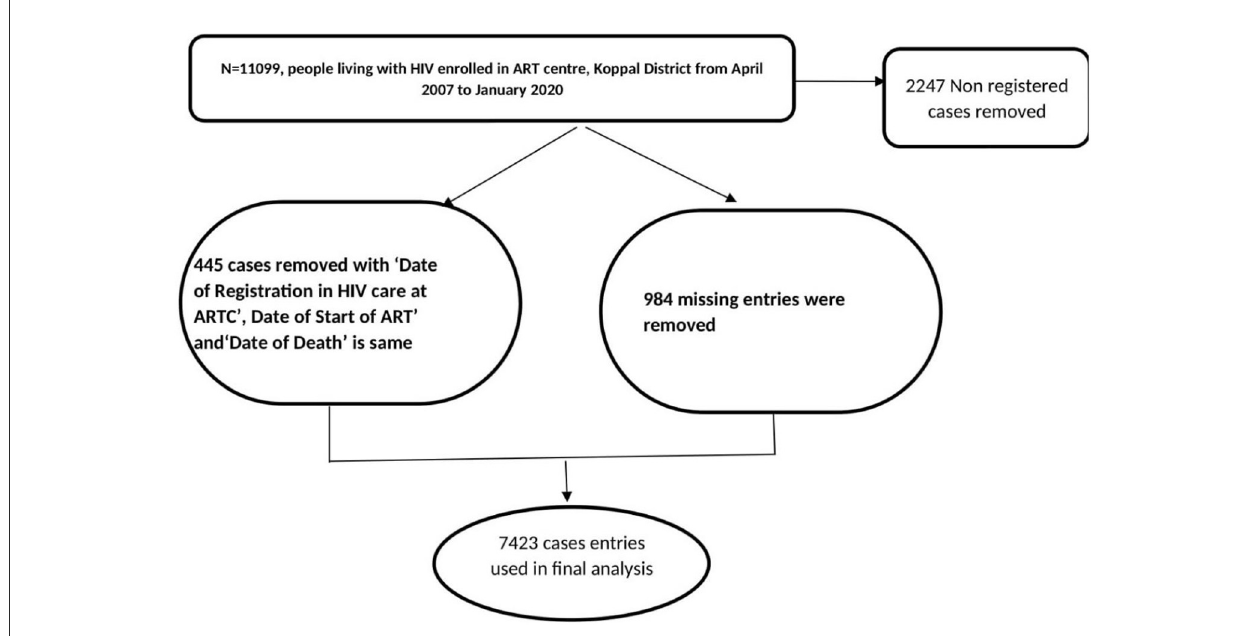
FIGURE1 Data extraction and